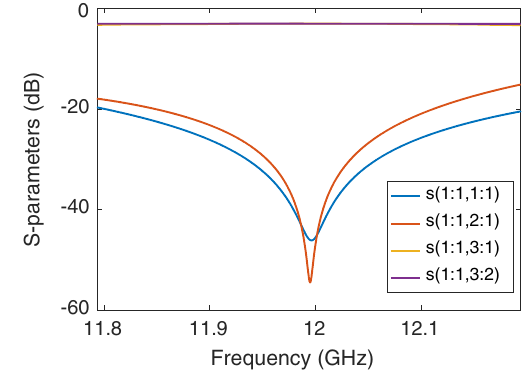
FIG. 12. S-parameters of the dual-mode polarizer.